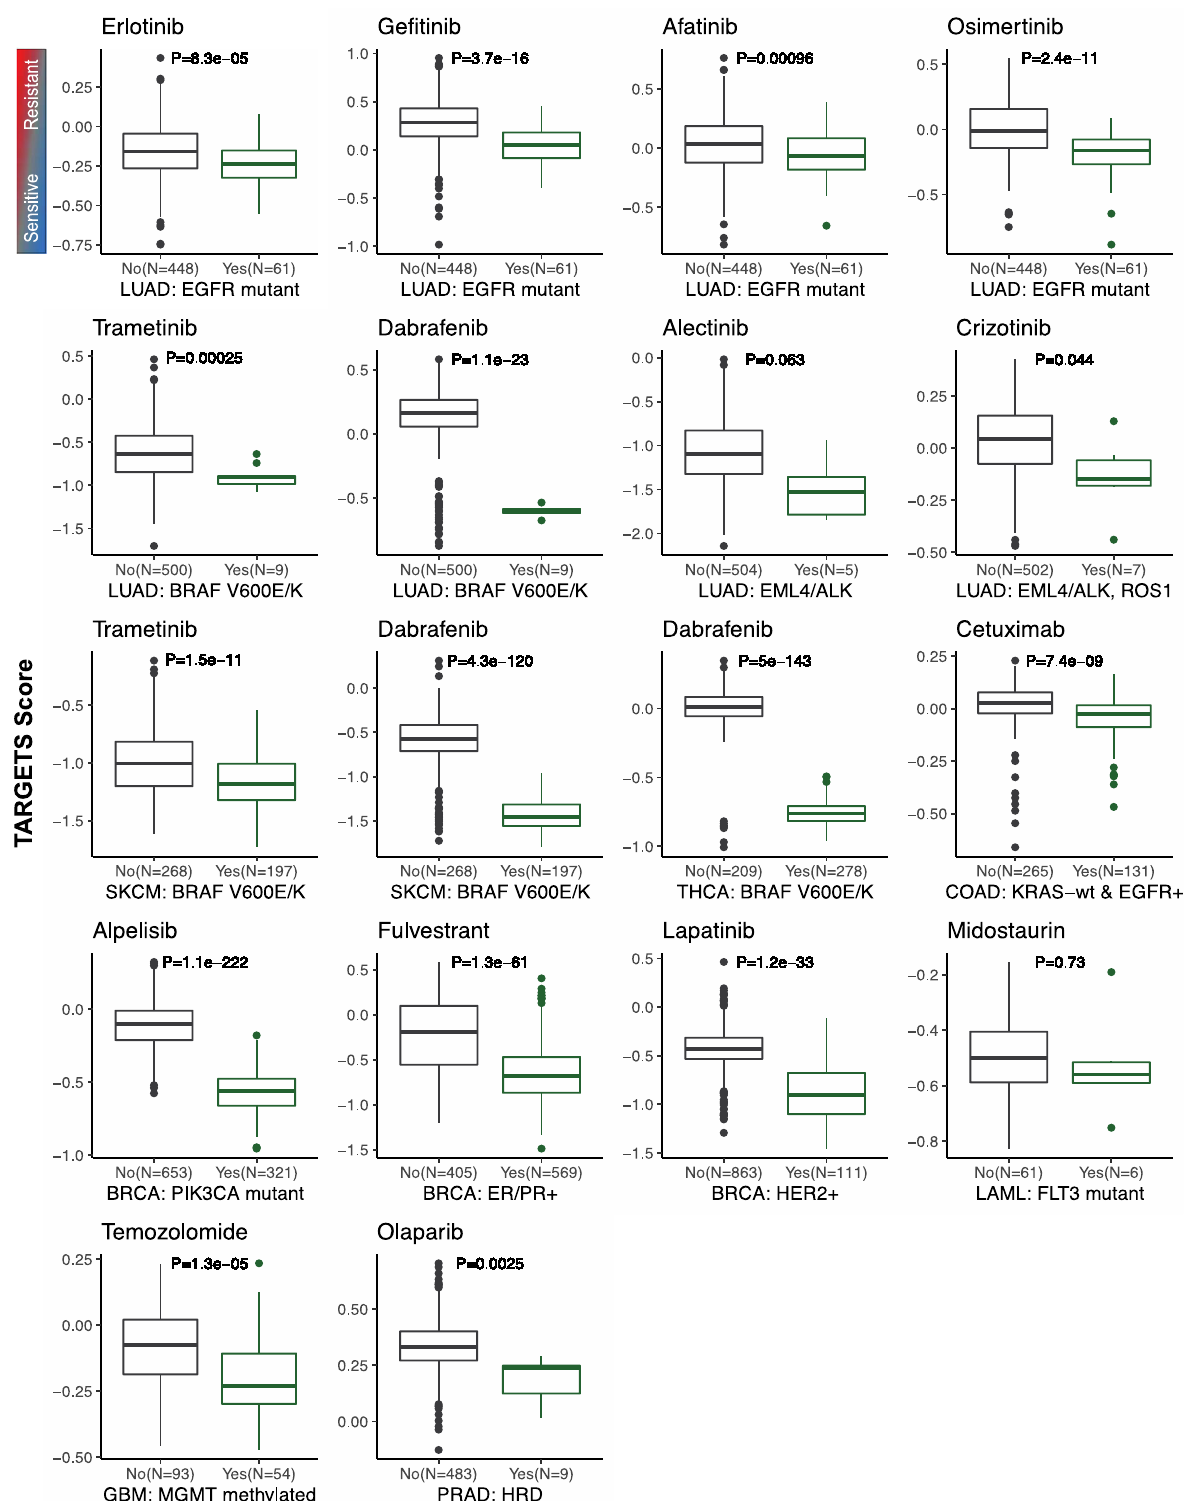
Fig. 3 TARGETS concordance with FDA-approved and clinically used biomarker indications. Boxplots comparing predicted TARGETS drug sensitivity among patients with or without a speci fi c biomarker. Distributions were compared using an unpaired two-sample t -test, with p -value reported. A lower TARGETS score indicates increased predicted sensitivity. Cancer site and type for each plot is identi fi ed using the TCGA standardized study abbreviations. Boxplot center line = median; box limits = upper and lower quartiles; whiskers = 1.5× interquartile